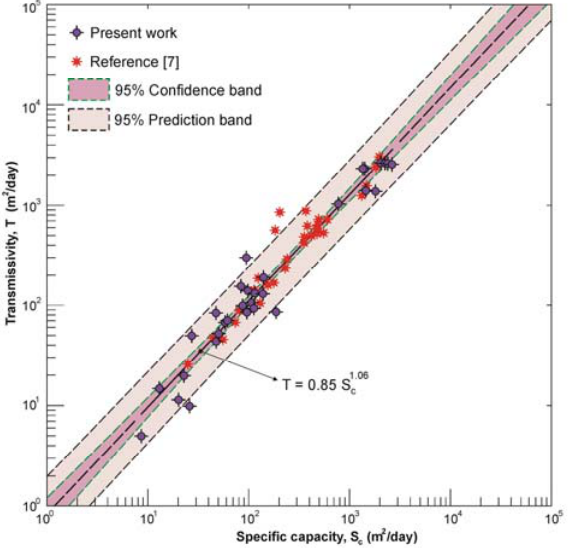
Figure 4. Relationship between specific capacity and transmissivity data for some carbonate aquifers in Italy. Data of Fabbri [7] are picked from [3] by using Engauge Digitizer free software.